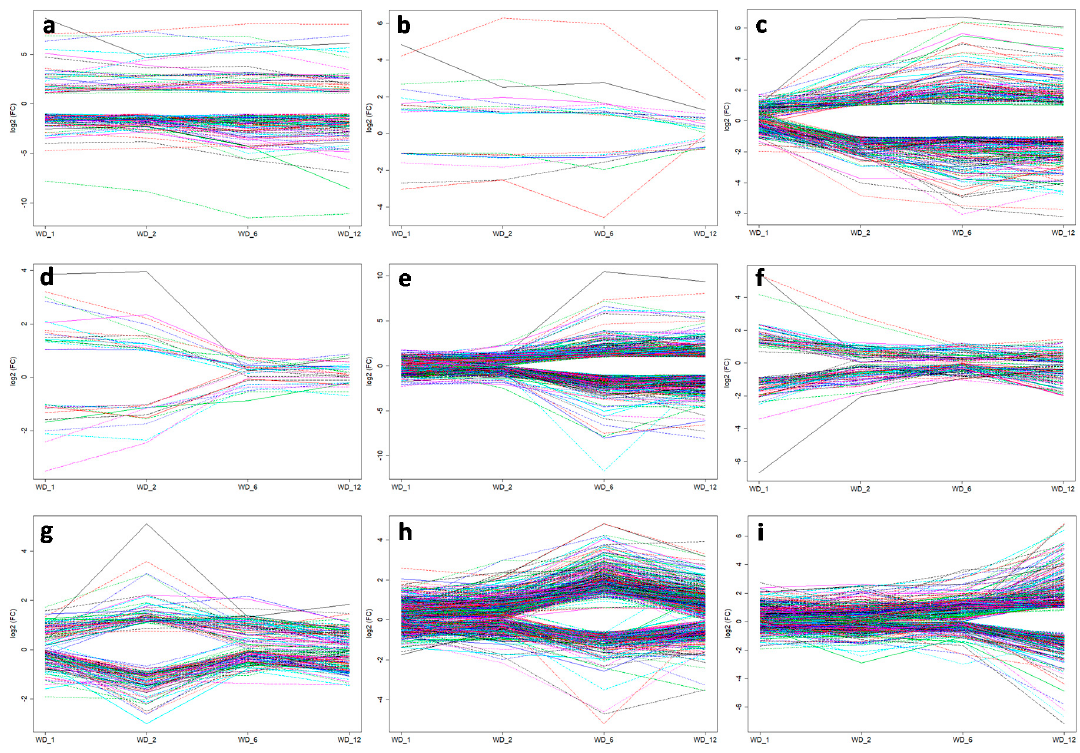
Figure 6. Expression of genes in different clusters. ( a ) cluster 1, genes regulated by all treatments; ( b ) cluster 2, genes regulated by short and intermediate heat treatments but not by long-term treatments; ( c ) cluster 3, genes not regulated by 1 hour heat shock, but by longer time of heat treatments after that; ( d ) cluster 4, genes regulated by the two short-term heat treatments, but not by the intermediate and long-term heat treatment; ( e ) cluster 5, genes regulated by intermediate and long-term heat treatments, but not by short-term heat treatments; ( f–i ) clusters 6–9, genes specifically regulated by 1, 2, 6, and 12 h of heat treatment, respectively. Different color lines indicated different genes.